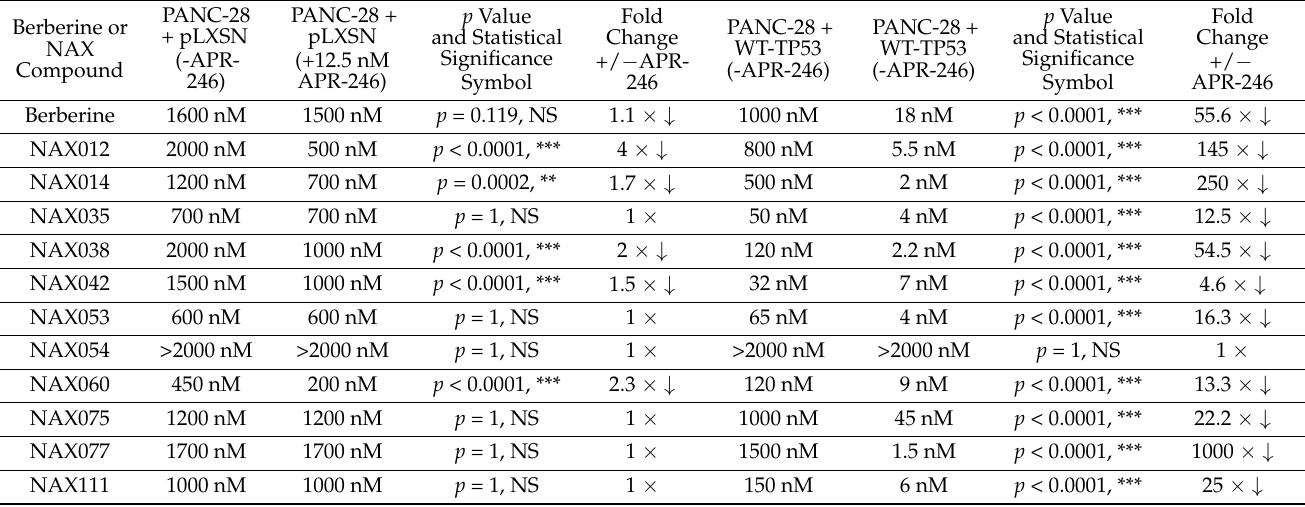
Table 2. Effects of WT-TP53 on the sensitivity of PANC-28 PDAC cells to APR-246 1